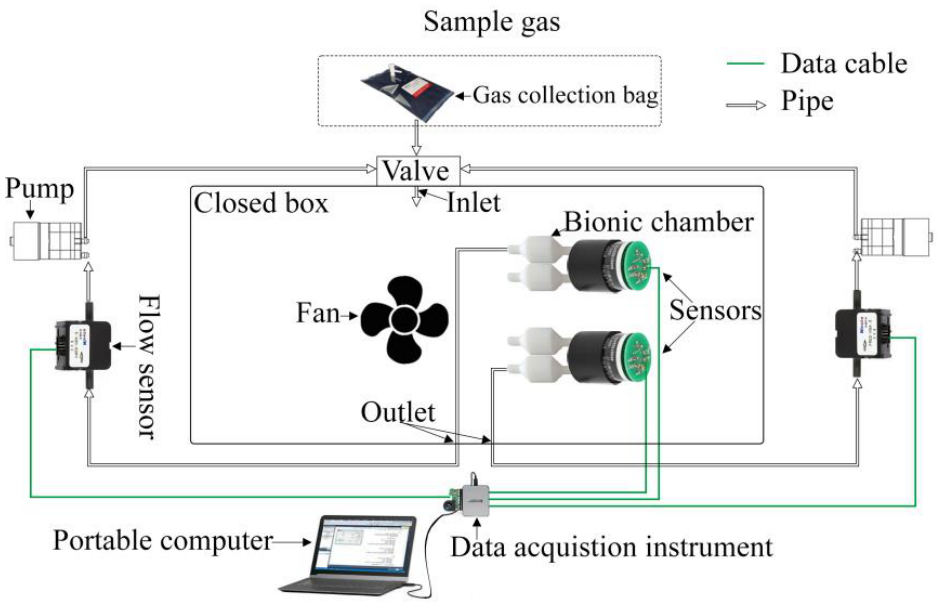
Figure 1. Schematic of the experimental electronic nose detection system.